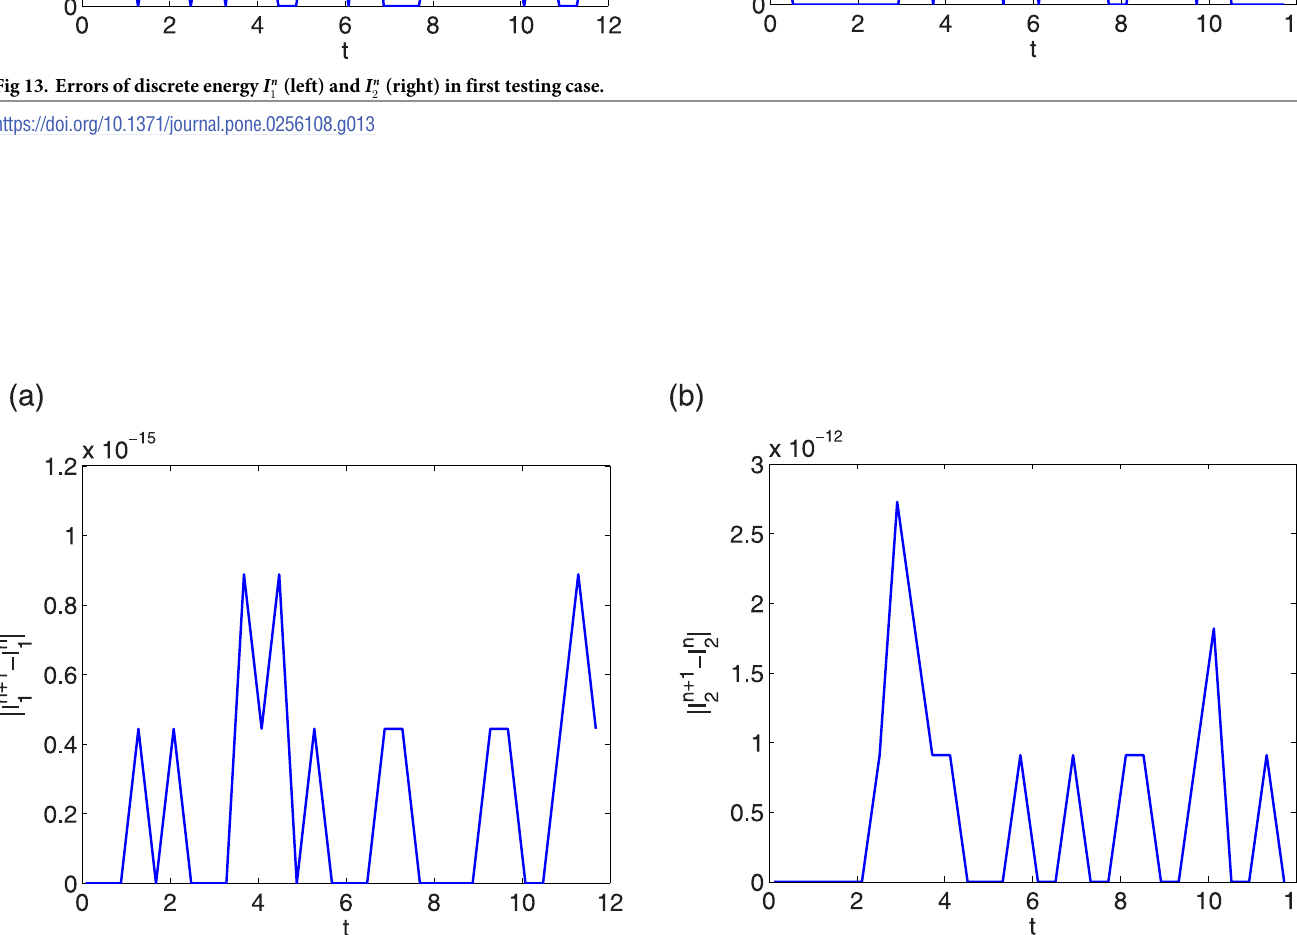
Fig 14. Errors of discrete energy I n